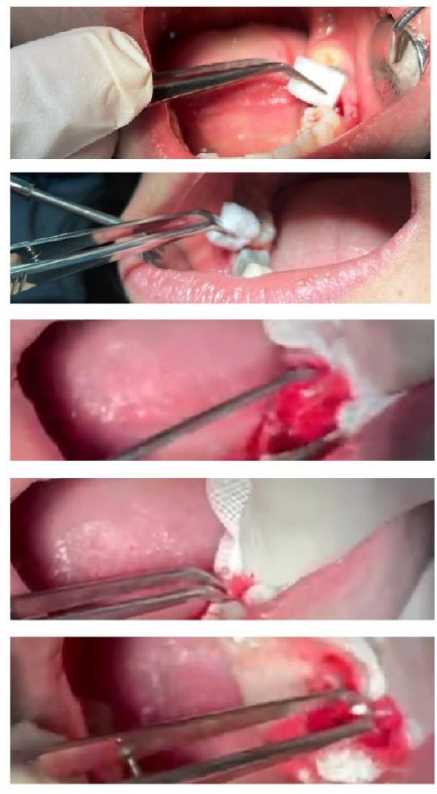
Figure 2. The process for clinical assessment.